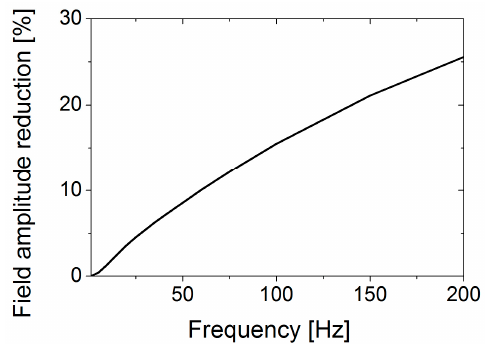
Figure 5. Relative reduction of the magnetic field amplitude due to a 0.5 mm aluminium shield for different excitation frequency values (FEM simulation).